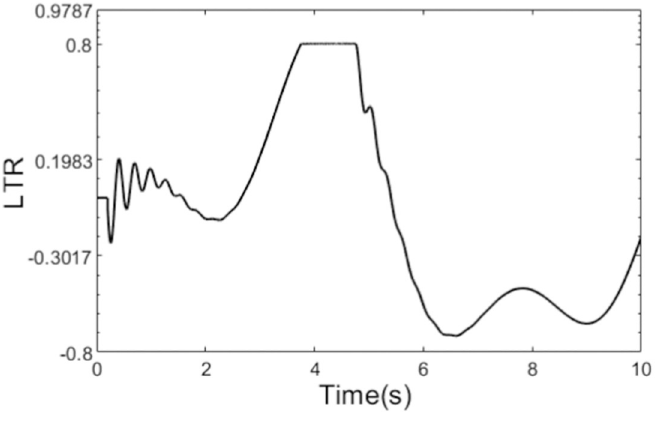
Fig 7. Real time value of